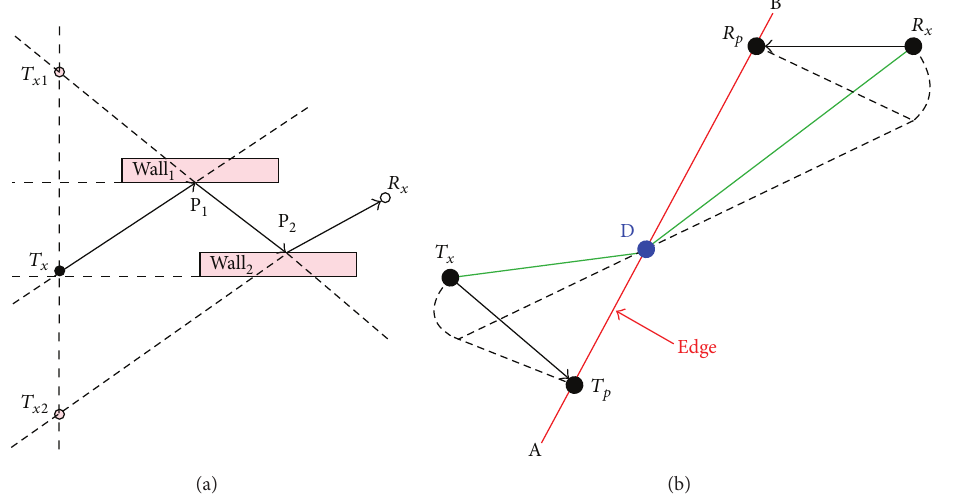
Figure 1: Path research technics: (a) source-image methods, (b) method of diffraction point computation.